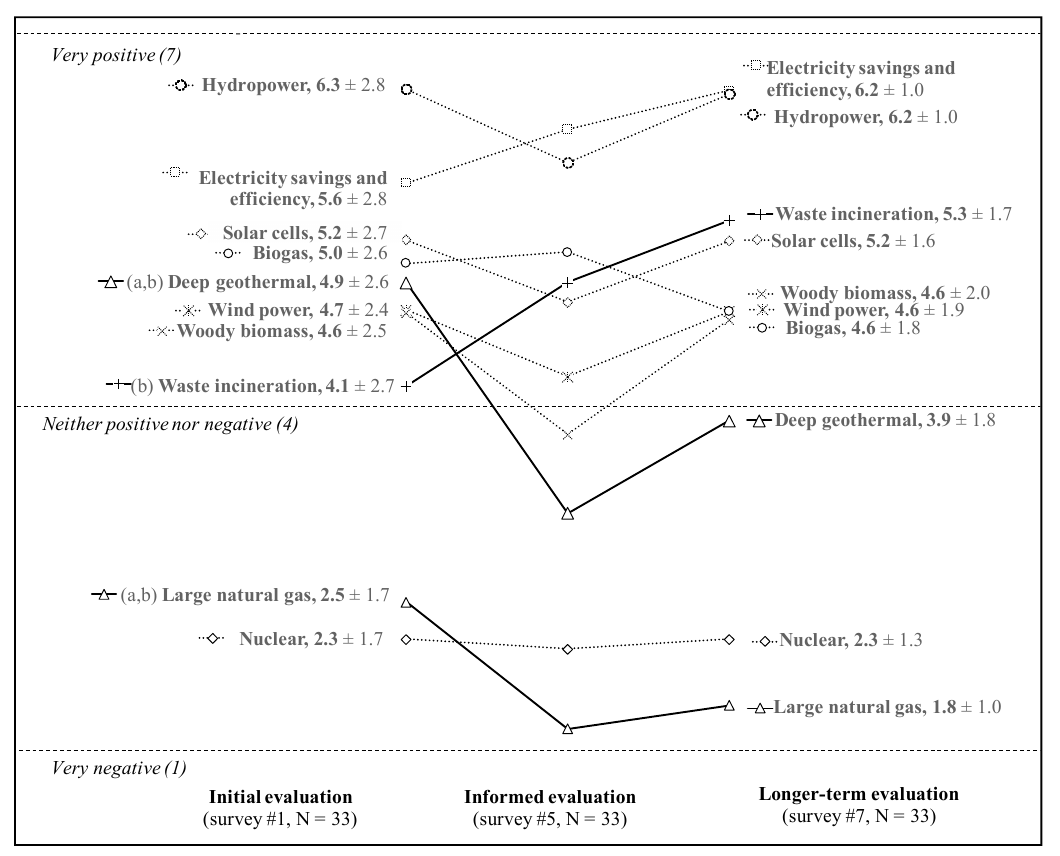
Figure 3. Average combined ratings of the informed citizen panel of image associations with technologies and affective evaluation of image associations (seven-point Likert scale, 1 = very negative to 7 = very positive). Statistically significant differences ( p < 0.05) are: (a) between survey #1 and survey #5; (b) between survey #1 and survey #7. The informed evaluation ratings are: hydropower = 5.7 ± 1.1, electricity savings = 6.0 ± 1.5, solar cells = 4.7 ± 1.3, biogas = 4.9 ± 1.5, deep geothermal = 3.2 ± 1.6, wind power = 4.2 ± 1.2, woody biomass = 3.8 ± 1.7, waste incineration = 4.9 ± 1.8, large natural gas = 1.7 ± 0.7, and nuclear = 2.2 ± 1.3.